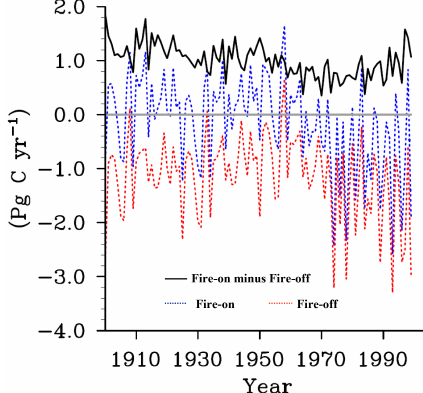
Fig. 2. Global totals of annual NEE in fire-on (blue) and fire-off (red) simulations for 1900–1999, and their differences (black). A negative value of NEE for fire-on and fire-off simulations indicates a land uptake of